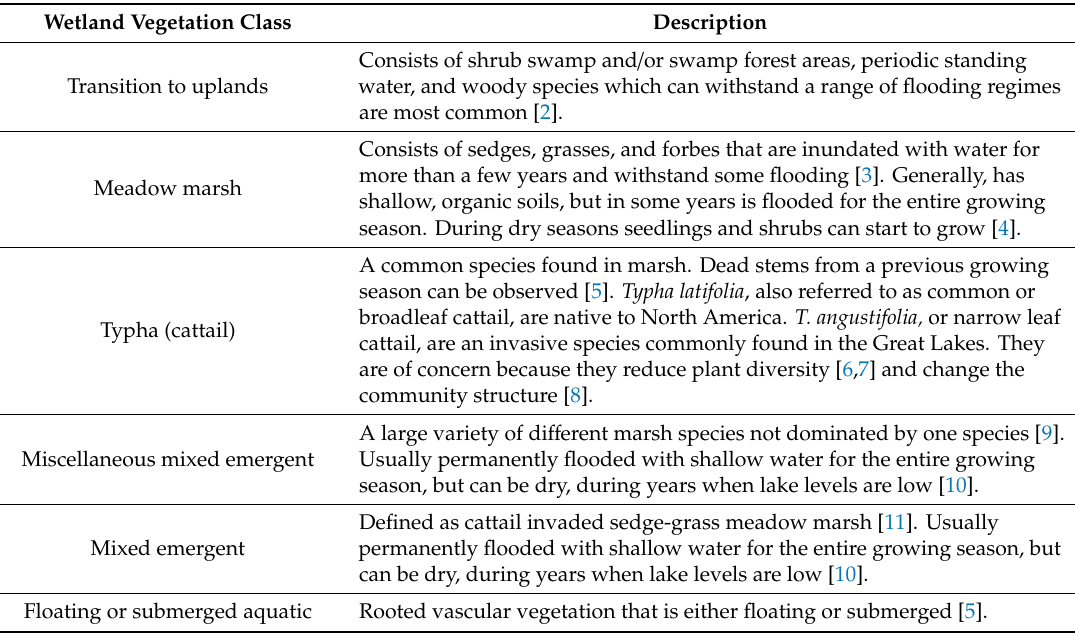
Table 1. A description of the wetland vegetation classes included in this